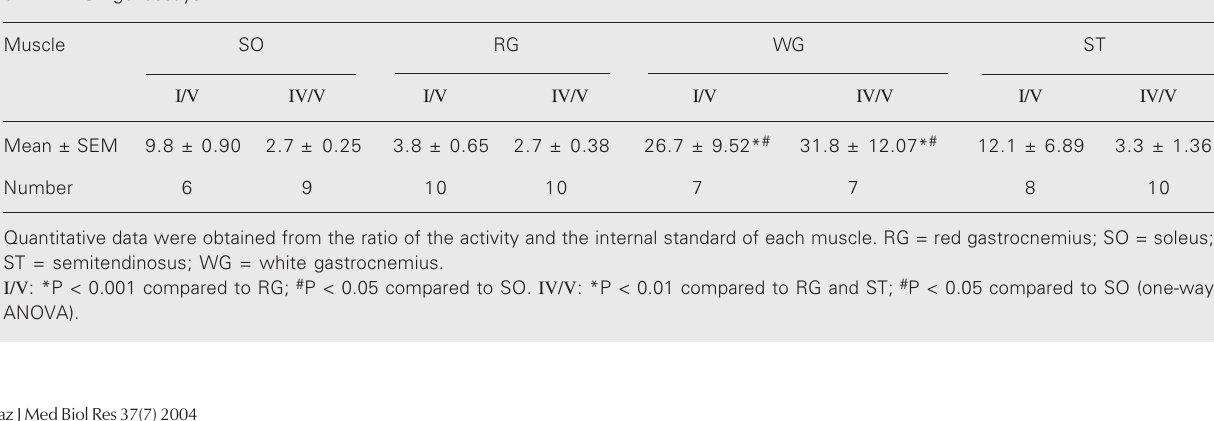
Table 3. Complex I (NADH dehydrogenase) and IV (cytochrome c oxidase) activities in rat muscles determined by colorimetric enzymatic staining of BN-PAGE gel assays. Muscle SO